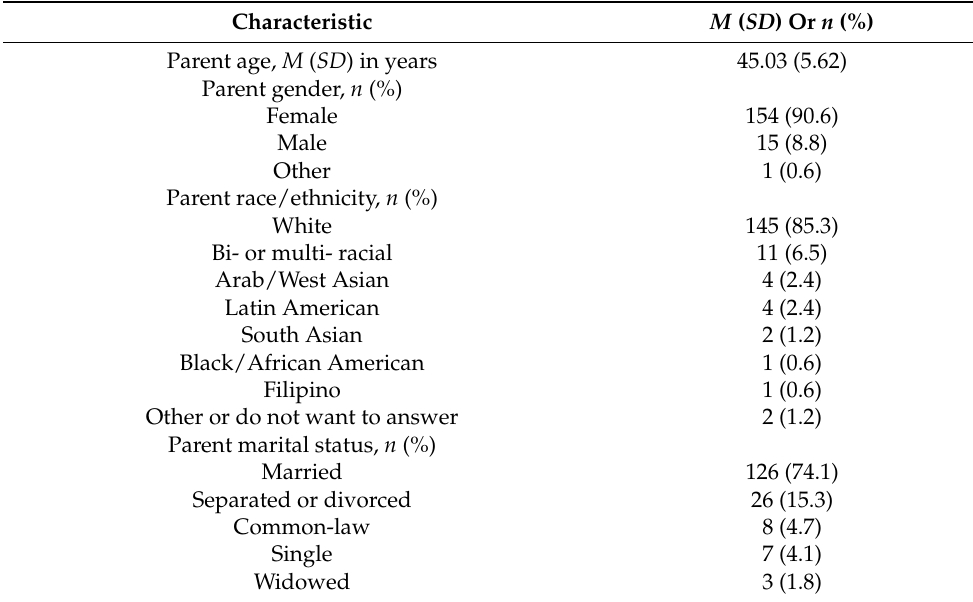
Table 1. Sociodemographic and pain characteristics of the sample, N =